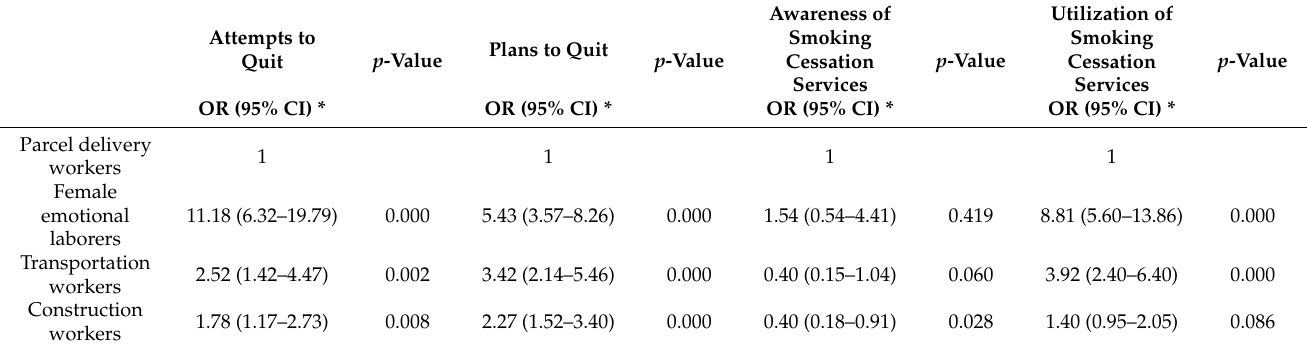
Table 5. Comparisons with parcel delivery workers as the most vulnerable